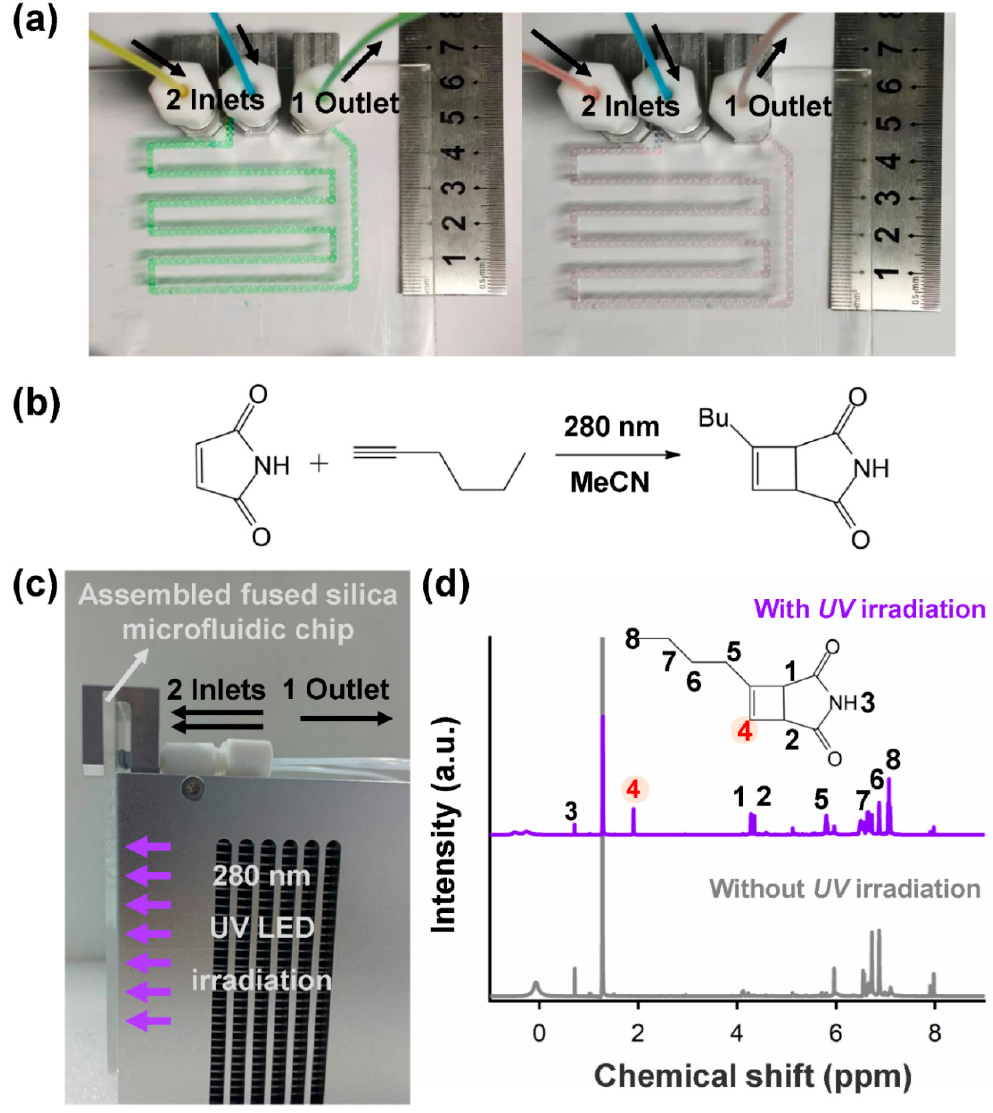
Figure 5. ( a ) Demonstration of high-efficiency mixing in a fused silica microfluidic chip with a size of 100 mm × 100 mm × 3 mm using different dye solutions. Left: yellow and blue dye solutions were pumped into two inlets with a flow rate of 20 mL/min, respectively; Right: red and blue dye solutions were pumped into two inlets with the same flow rate, respectively. ( b ) a [2 + 2] photocycloaddition reaction for continuous-flow photochemical synthesis. ( c ) Photo of an assem- bled fused silica microfluidic chip and a UV LED light source for on-chip photochemical